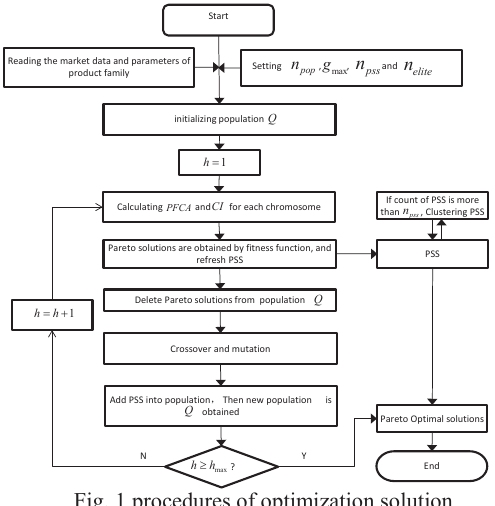
Fig. 1 procedures of optimization